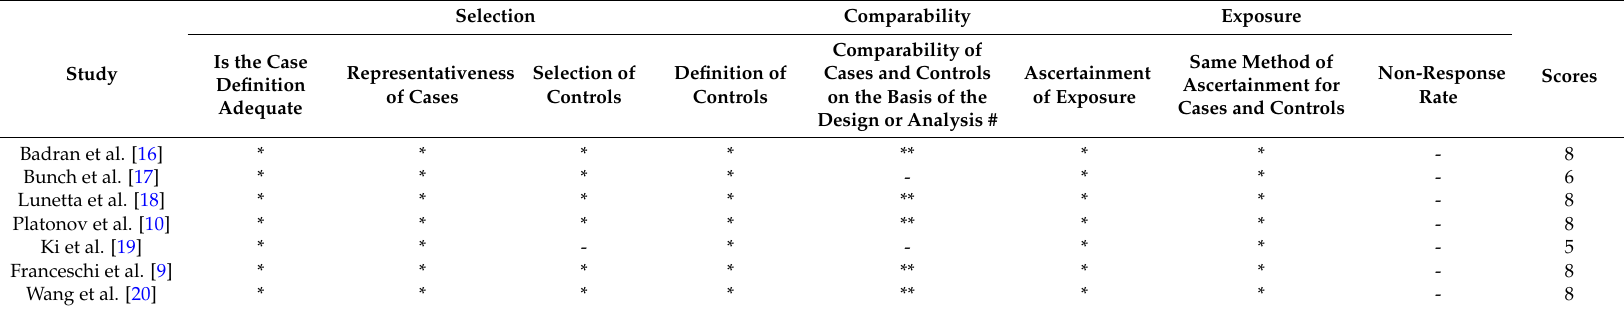
Table 2. Results of quality assessment by Newcastle-Ottawa quality assessment scale (NOS) for case-control